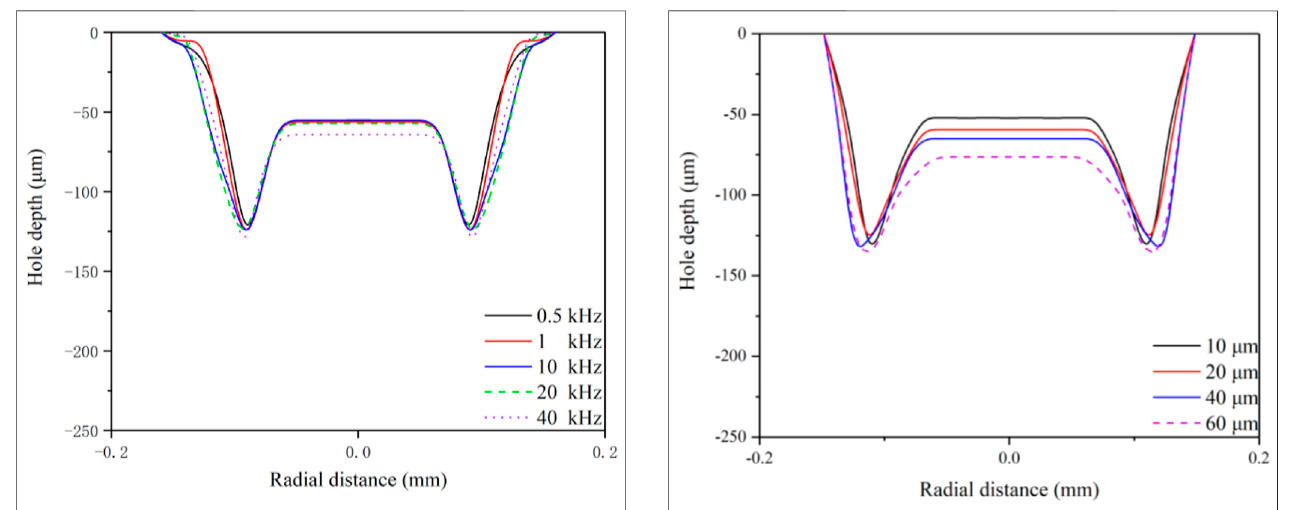
Frontiers in Materials |